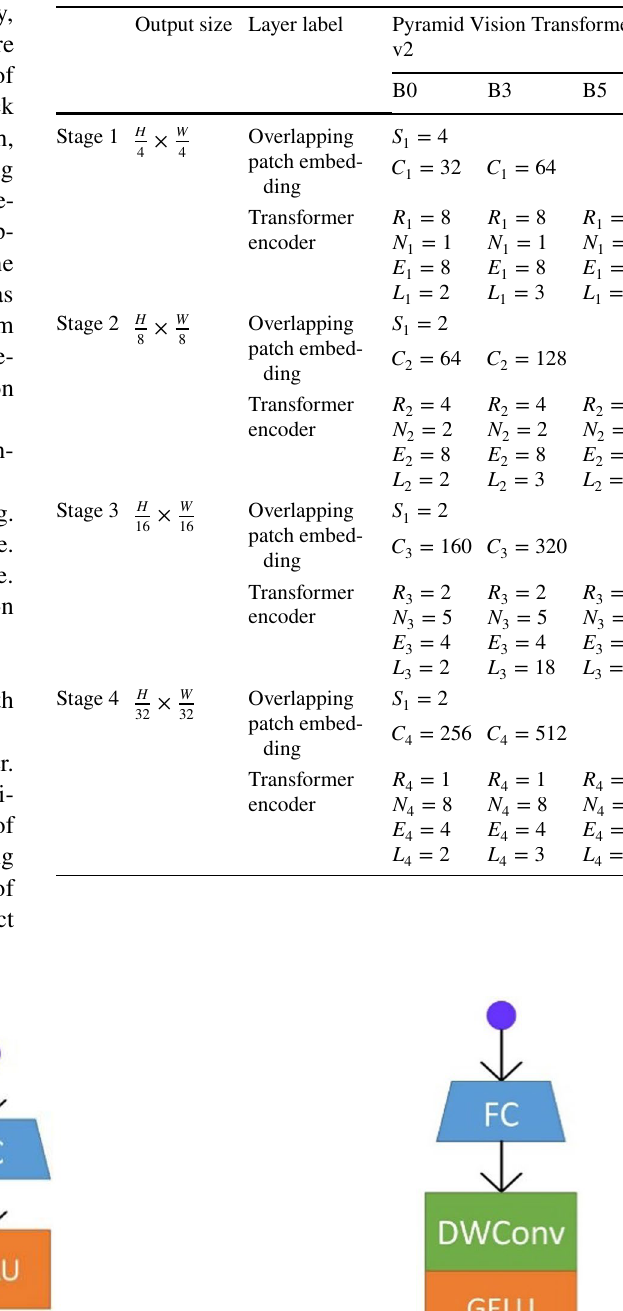
Table 1 Overall network architecture of